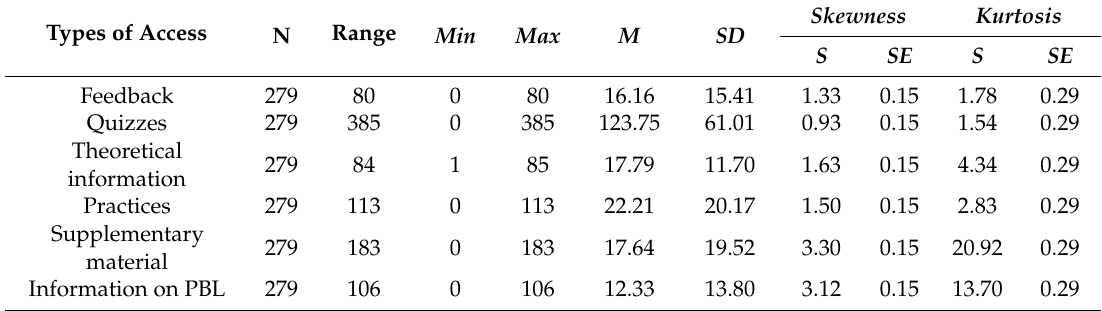
Table 2. Analysis of the parameters of asymmetry and kurtosis normality in the types of access to the